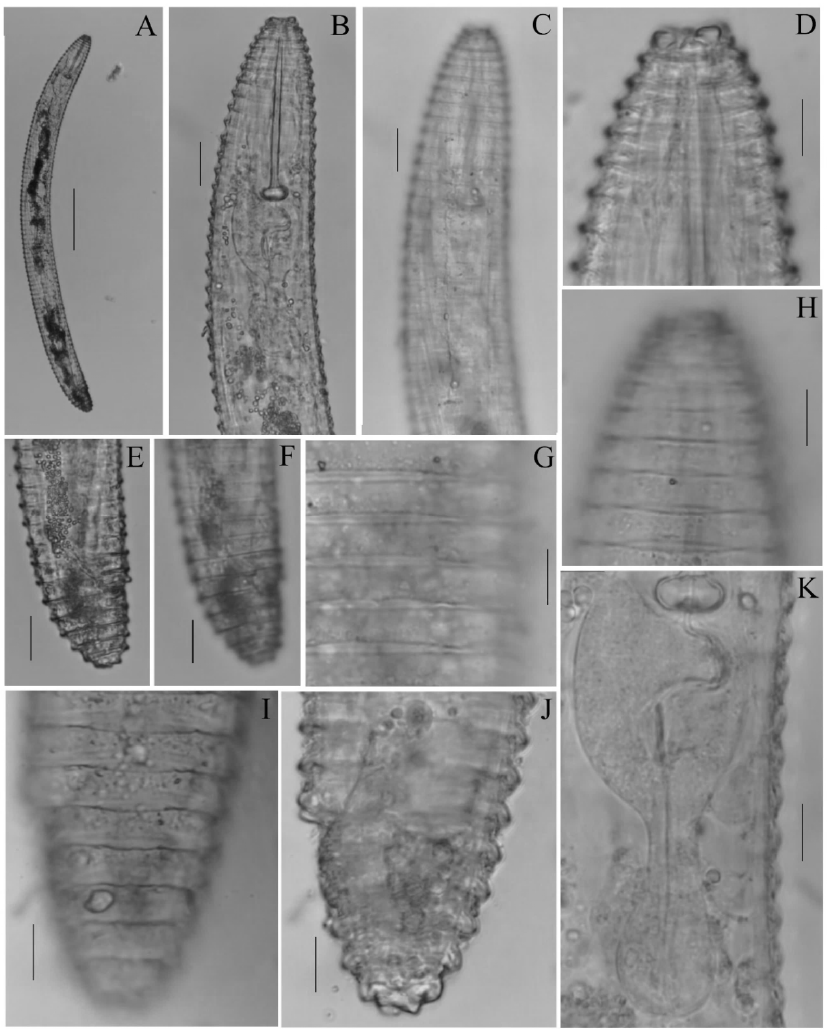
Figure 2. Diagnostic characters in the females of Mesocriconema antipolitanum . ( A ): Total body; ( B ) and ( C ): detail of the anterior end stylet and pharyngeal region; ( D , H ): head with big sub-median lobes; ( E , F , I , H ): posterior end, vulva, and tail region; ( G ): surface margins; and ( K ): pharyngal region. (Scale bars: ( A – C , E , F ) = 100 µ m; ( D , G , K ) = 20 µ m). Female: The body annuli retrorse; about 4.5 µ m thick at the anterior end and 10 µ m thick in the middle of the body. Annuli smooth and rounded; generally, 0–3